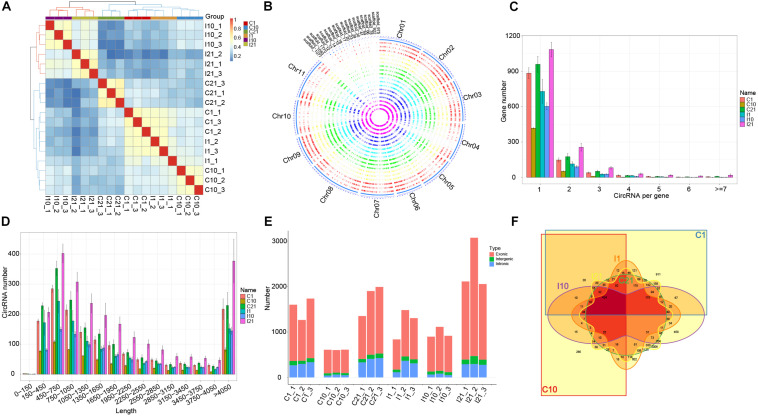
Characteristics of circRNA in roots and nodules of common bean. (A) Correlation coefficients for biological repeats of the six treatment groups. (B) Circos diagram showing the distribution and expression levels of circRNAs identified in the common bean genome. (C) Number of circRNAs produced per gene. (D) Length distribution of circRNAs. (E) Number of exonic circRNAs, intergenic circRNAs, and intronic circRNAs in each sequenced sample. (F) Venn diagram showing the number and distribution of circRNAs in the six treatment groups.